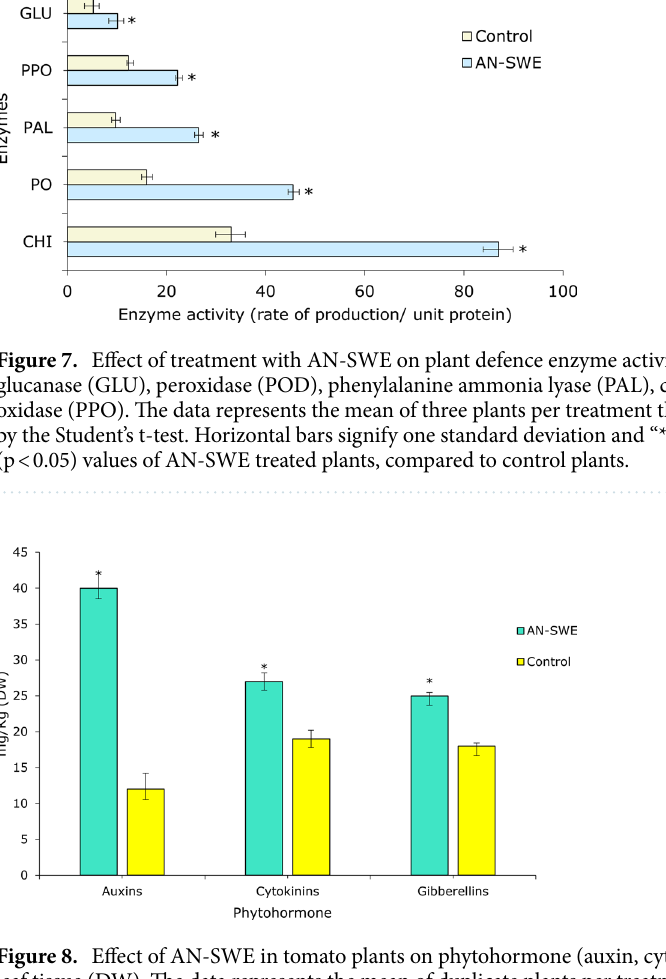
Figure 8. Effect of AN-SWE in tomato plants on phytohormone (auxin, cytokinin and gibberellin) levels in leaf tissue (DW). The data represents the mean of duplicate plants per treatment ± SD and was analysed for significance using the Student’s t-test where p < 0.05.